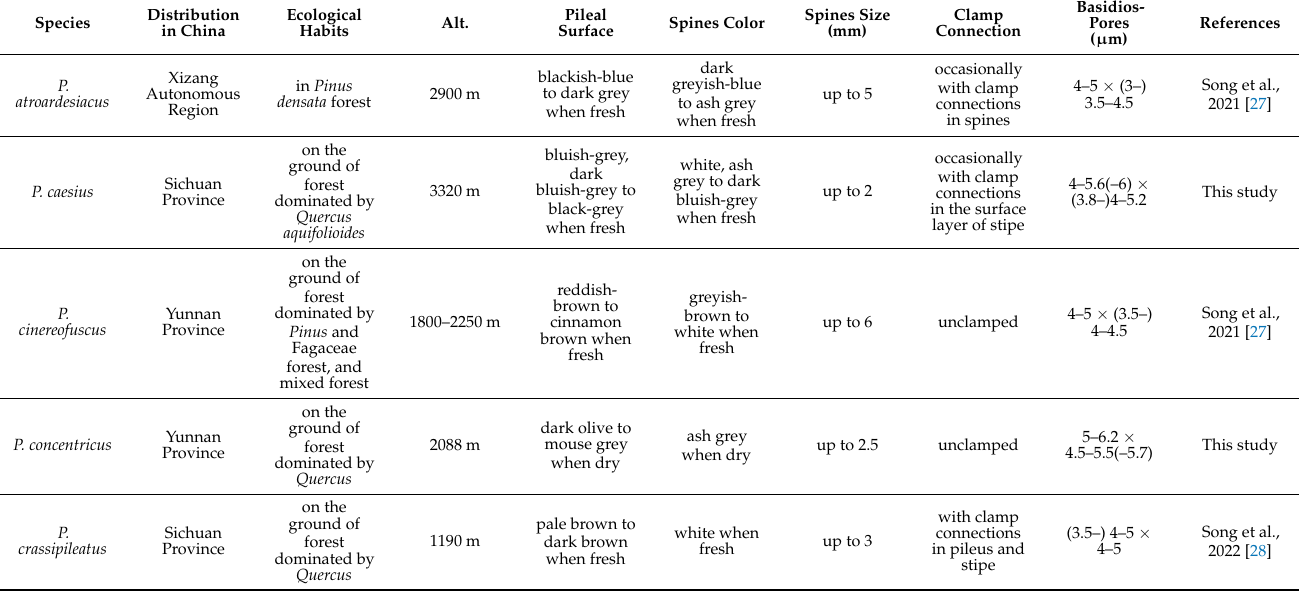
Table 2. The main morphological characteristics of species in Phellodon described in